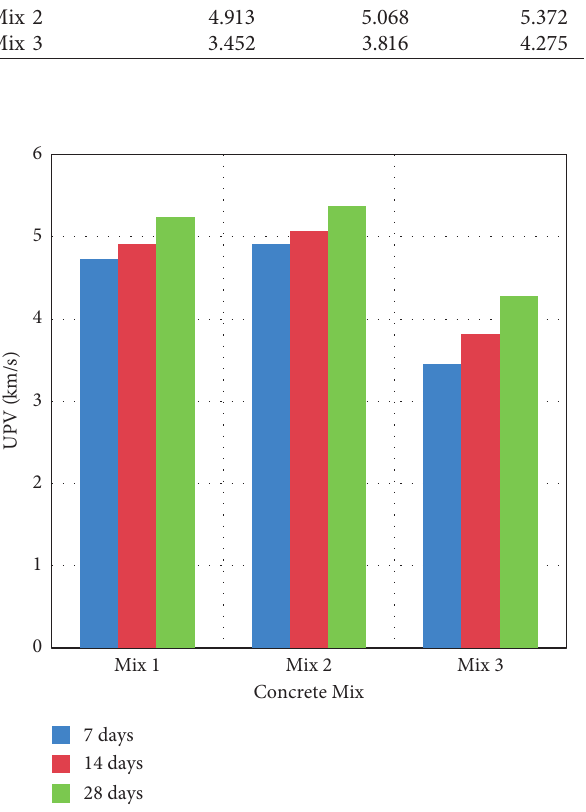
Figure 1: UPV values for OPC for different mix proportions.